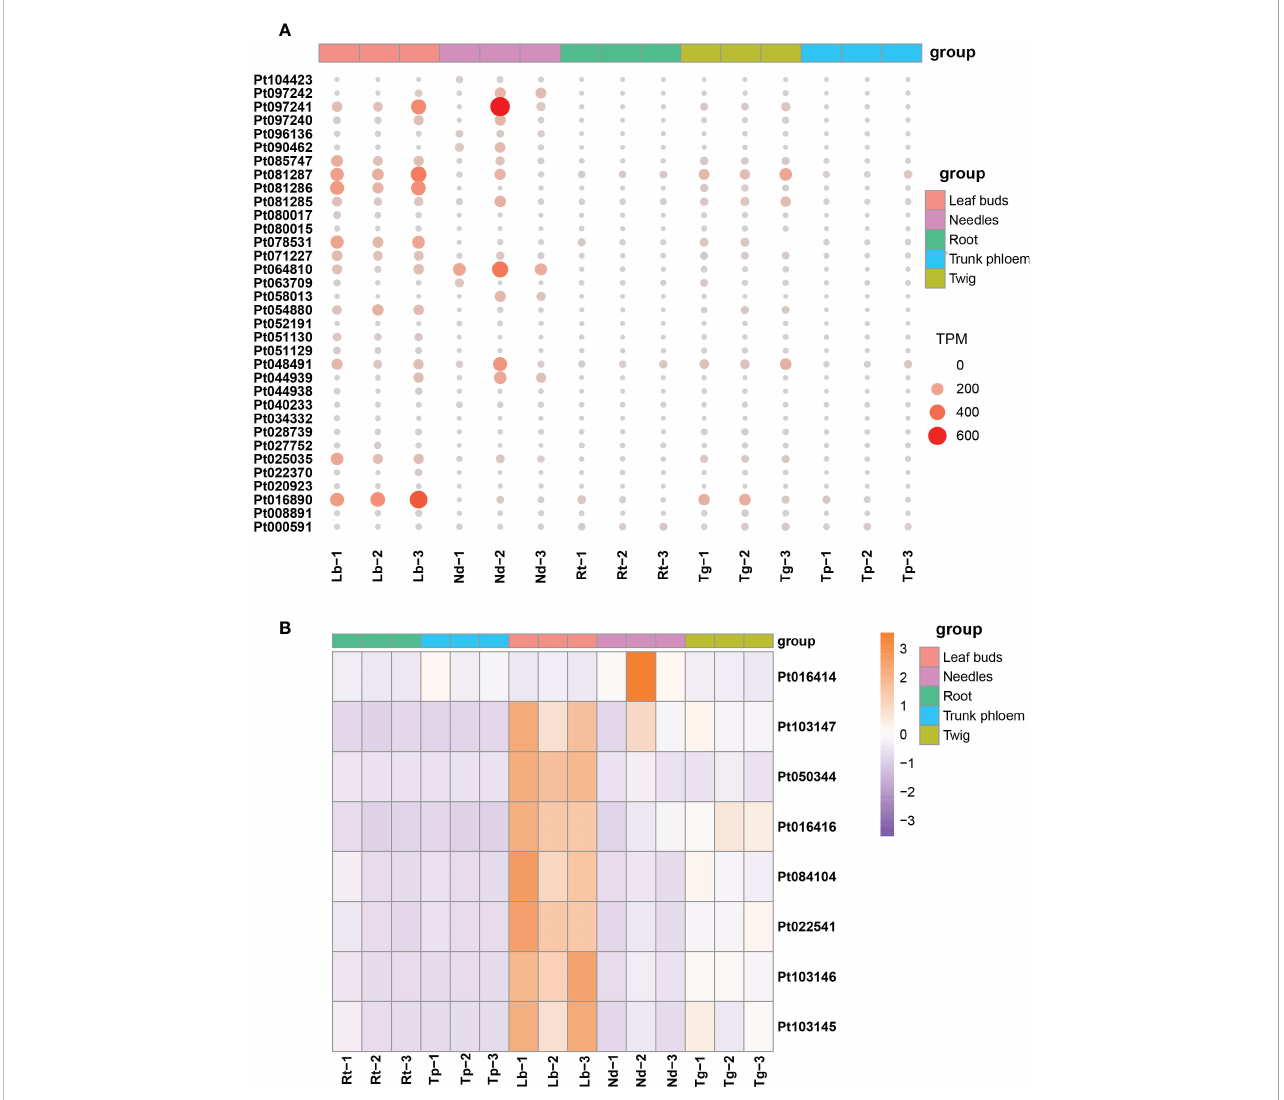
FIGURE 6 The expression pro fi les for TPS and P450 genes in different tissues of Pinus taeda . (A) Expression levels of TPS genes in fi ve tissues of Pinus taeda . (B) The heatmap for P450 genes in different tissues of Pinus taeda